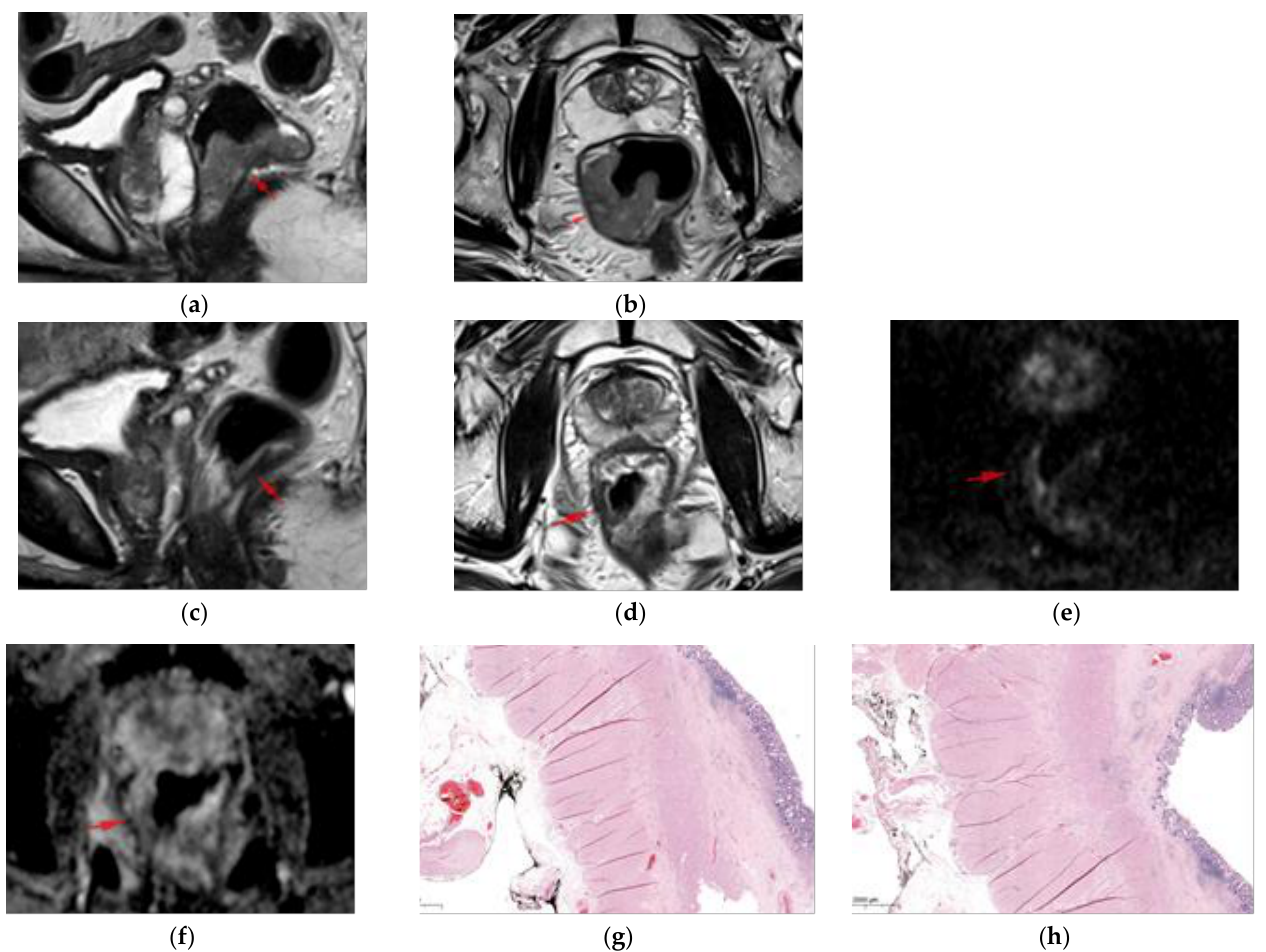
Figure 1. Flowchart of treatment and tumor assessments for included patients. nCRT = neoadjuvant chemoradiotherapy; pTRG = pathologic tumor regression grade; mrTRG = MRI tumor regression grade; TN = true negative; FP = false positive; TP = true positive; FN = false negative; CR = complete response; nCR = near-complete response; PR = partial response. A patient with CR at restaging MRI, confirmed by the histopathological report from surgery, is presented in Figure 2.